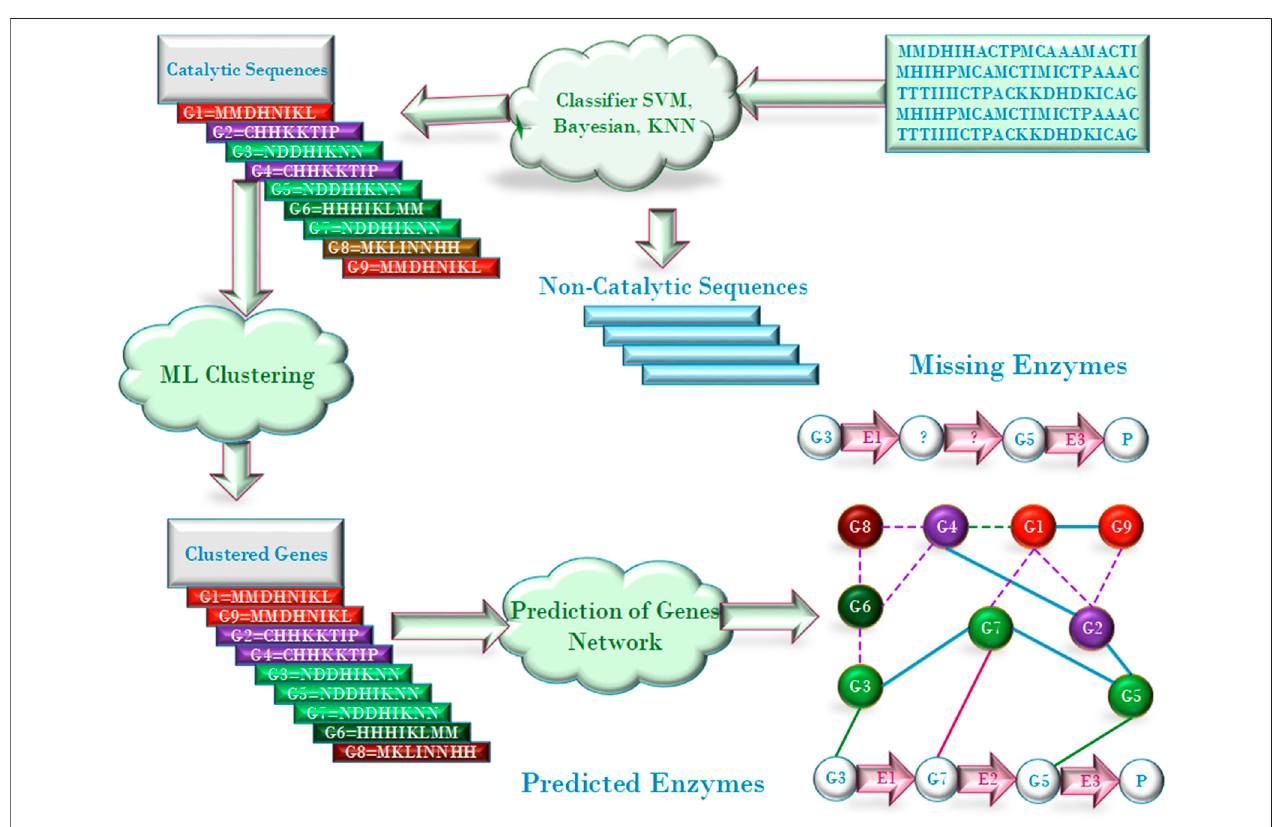
FIGURE 2 | Schematic illustration of ML-based